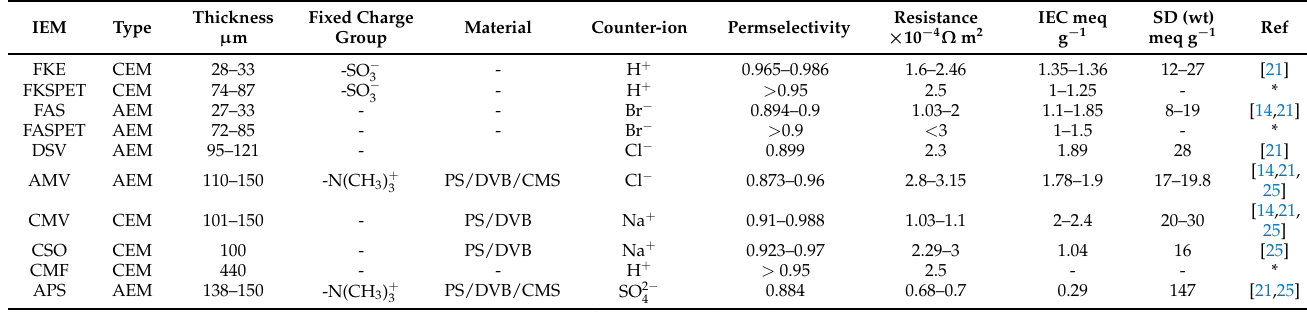
Table 1. Overview of the membranes examined in this work. The membrane resistance and permselectivity values extracted from manufacturer’s data sheet are tested in 0.5M NaCl at 298K and 0.5M/0.1M NaCl at 298K, respectively.